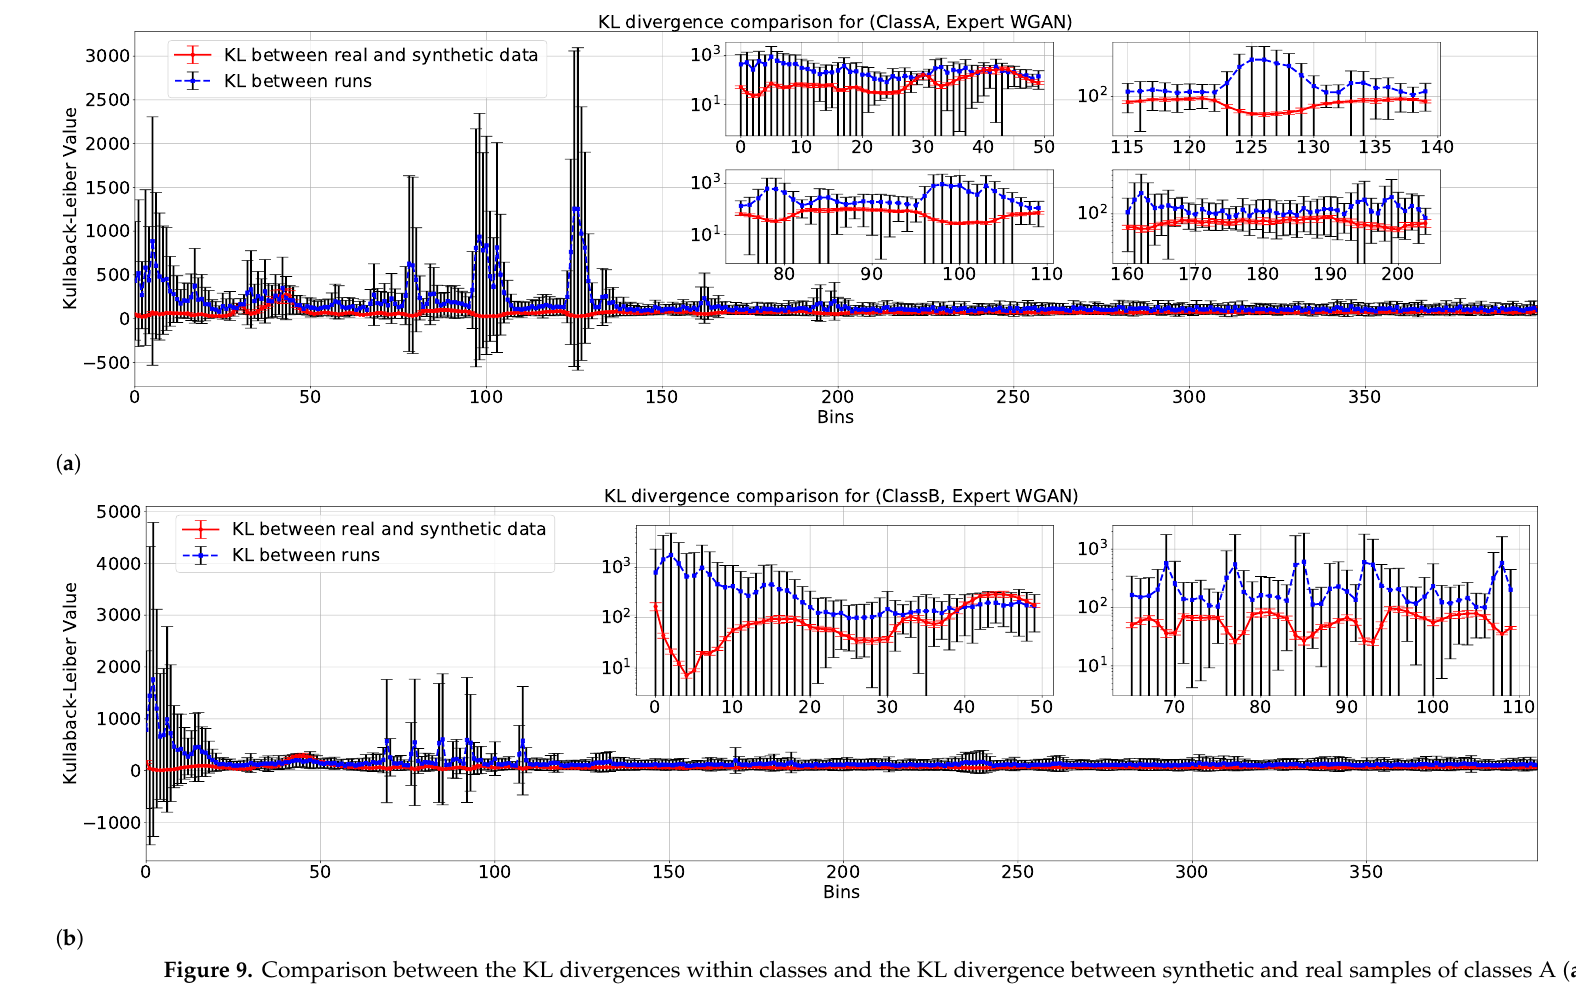
Figure 9. Comparison between the KL divergences within classes and the KL divergence between synthetic and real samples of classes A ( a ) and B ( b ) for the LORO-based